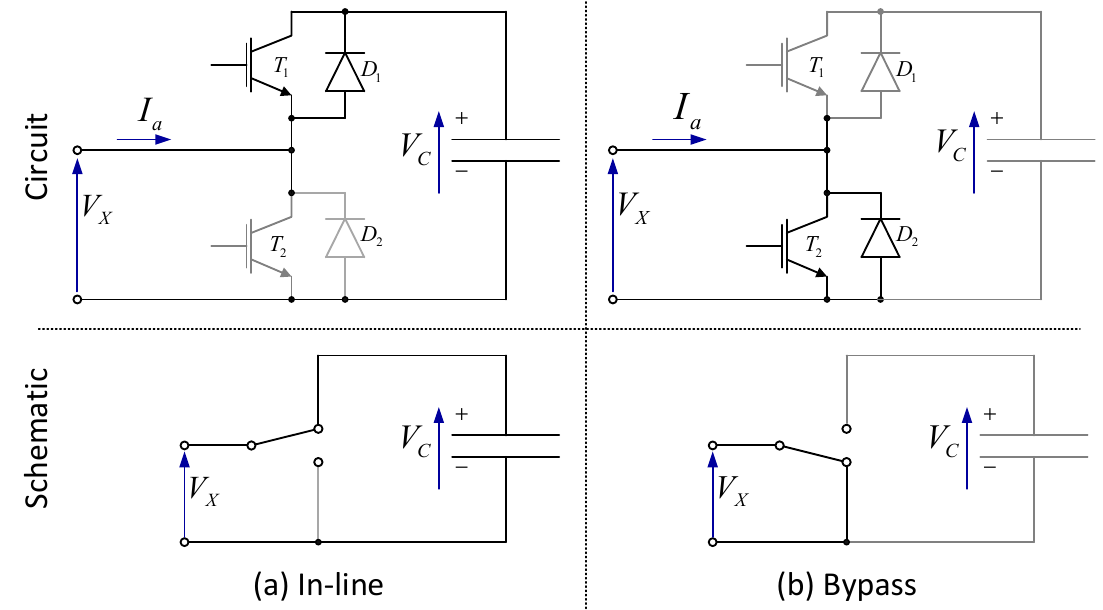
Figure 22. Multilevel Modular Converter (MMC): ( a ) Topology; ( b ) Submodule.